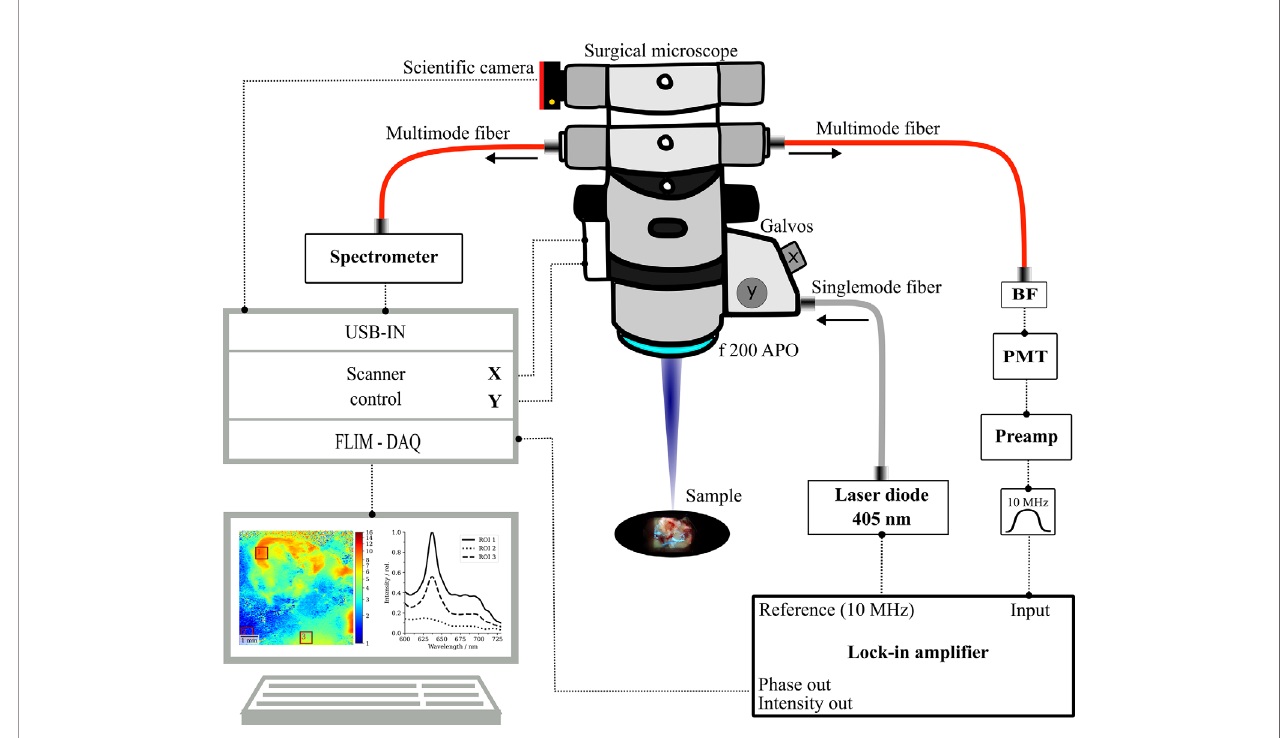
FIGURE 1 | Schematic sketch of the multimodal surgical microscope with integrated fl uorescence lifetime imaging and spectroscopy channels. BF, bandpass fi lter; PMT, photomultiplier tube; DAQ, data acquisition system, f 200 APO, apochromatic